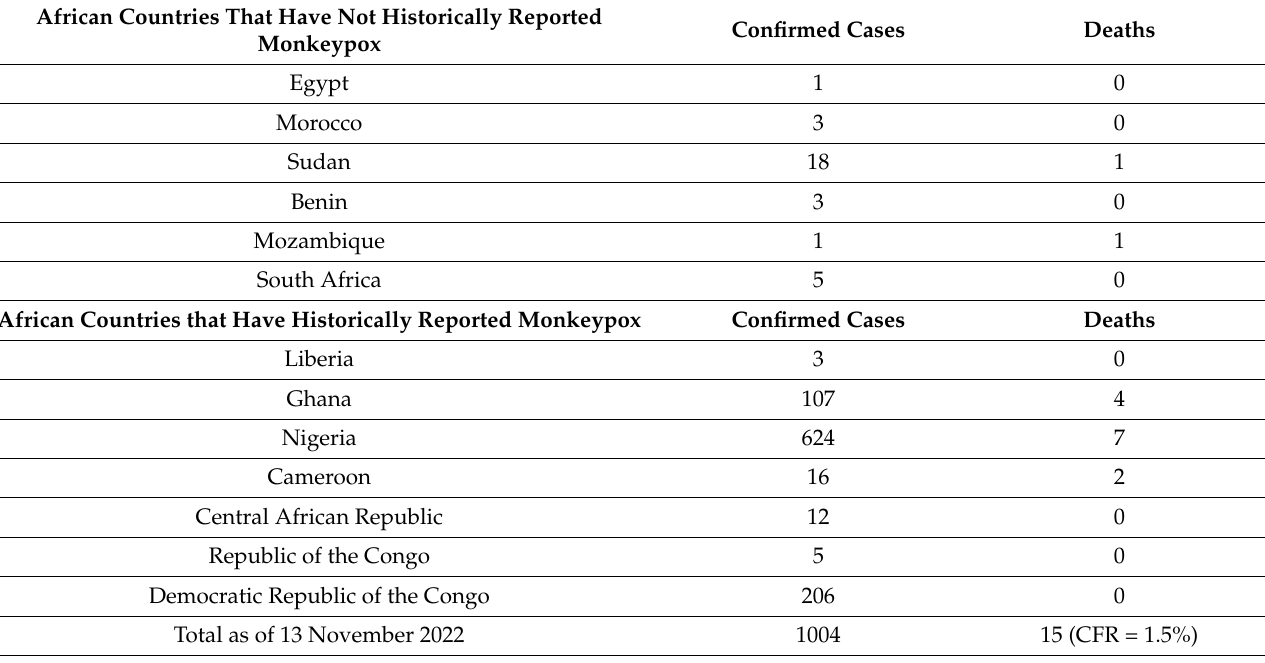
Table 2. The 2022 MPXV outbreak in